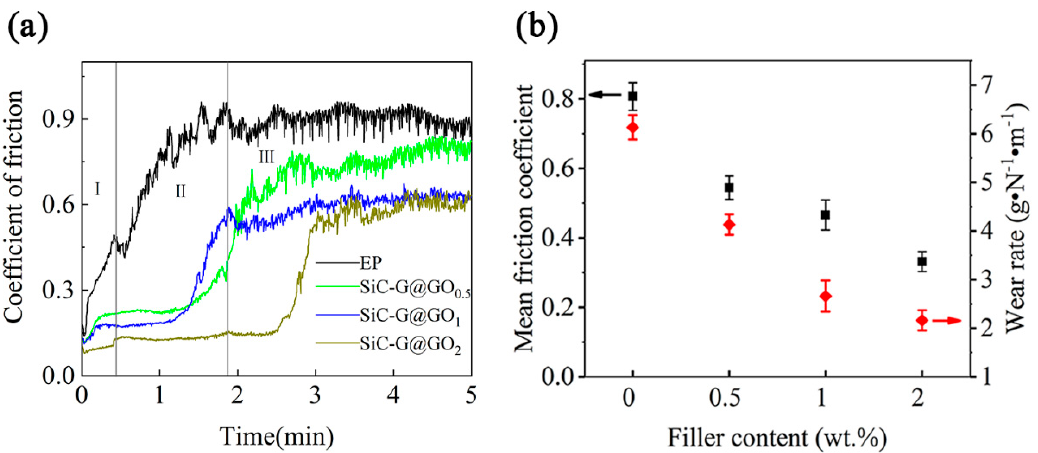
Figure 17. Tribological properties of the experimental coatings: ( a ) kinetic friction coefficient; ( b ) average friction coefficient and wear rate.